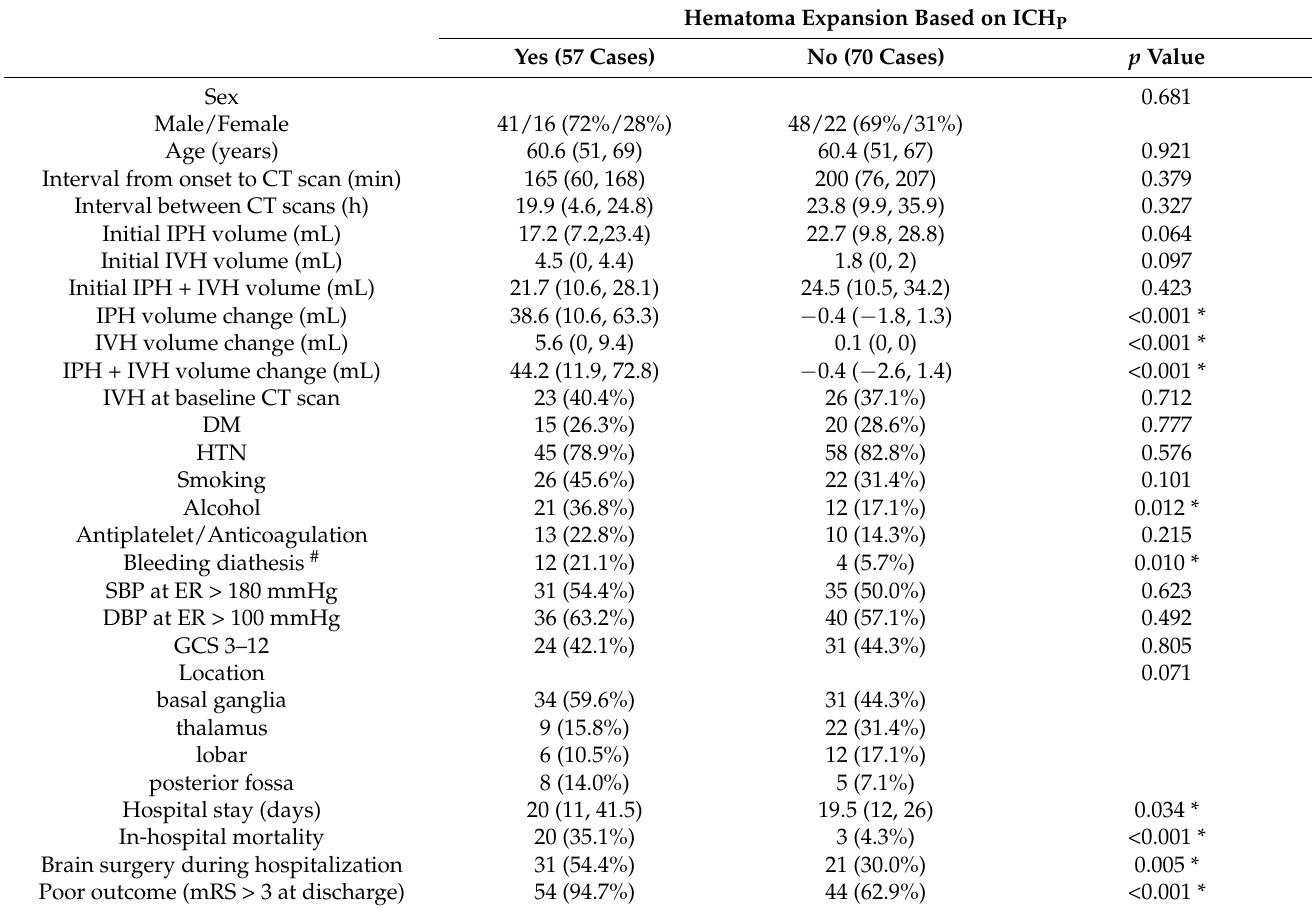
Table 1. The clinical parameters, hematoma information and short-term outcomes of 127 sICH patients based on ICH P